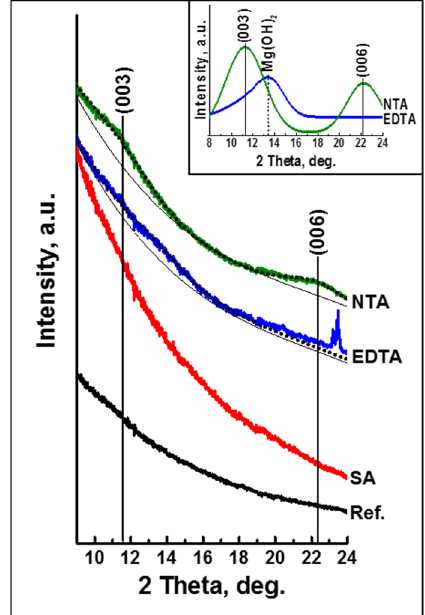
Figure 18. Grazing incidence XRD pattern of the AZ91 surface after 48 h in the reference, salicylic acid, EDTA, and NTA sodium salt solutions at room temperature. The data were shifted vertically for clarity. The inset shows the Gaussian polynomial fit of the NTA and EDTA patterns. Reprinted from [385] with permission from Springer Nature.